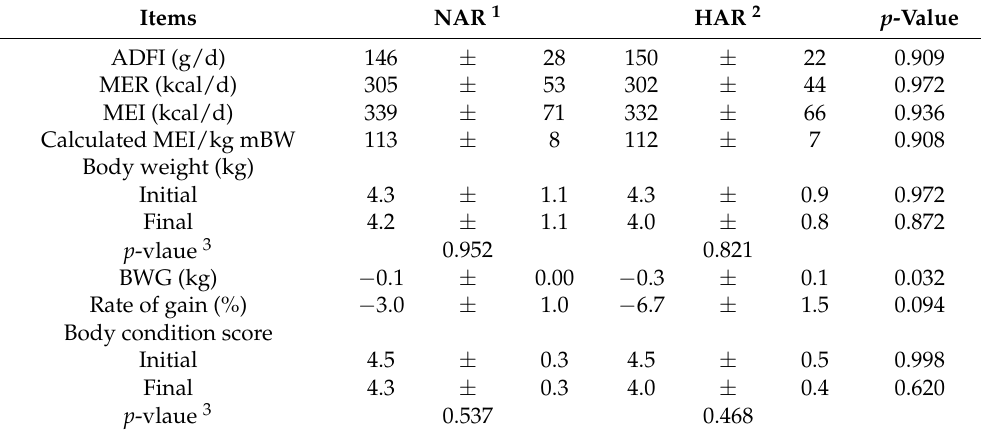
Table 6. Effects of high amylose type rice on feed intake and body parameters in dogs (Exp. 2).